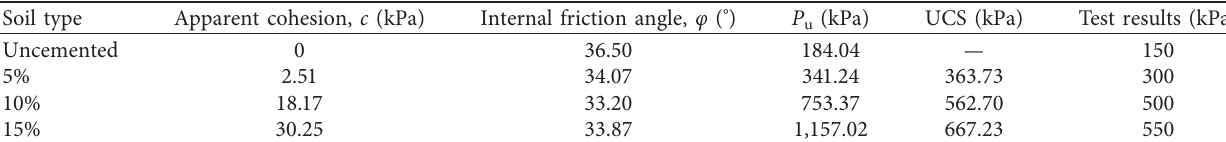
Figure 15: Deformation modulus of different cement stabilized calcareous sand foundations. Table 8: Comparison of ultimate bearing